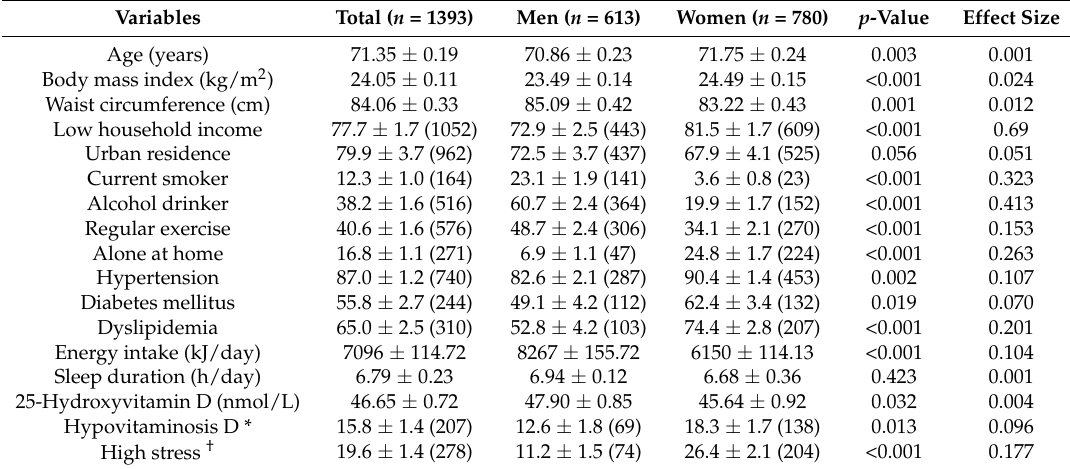
Table 1. General characteristics of study participants by sex.